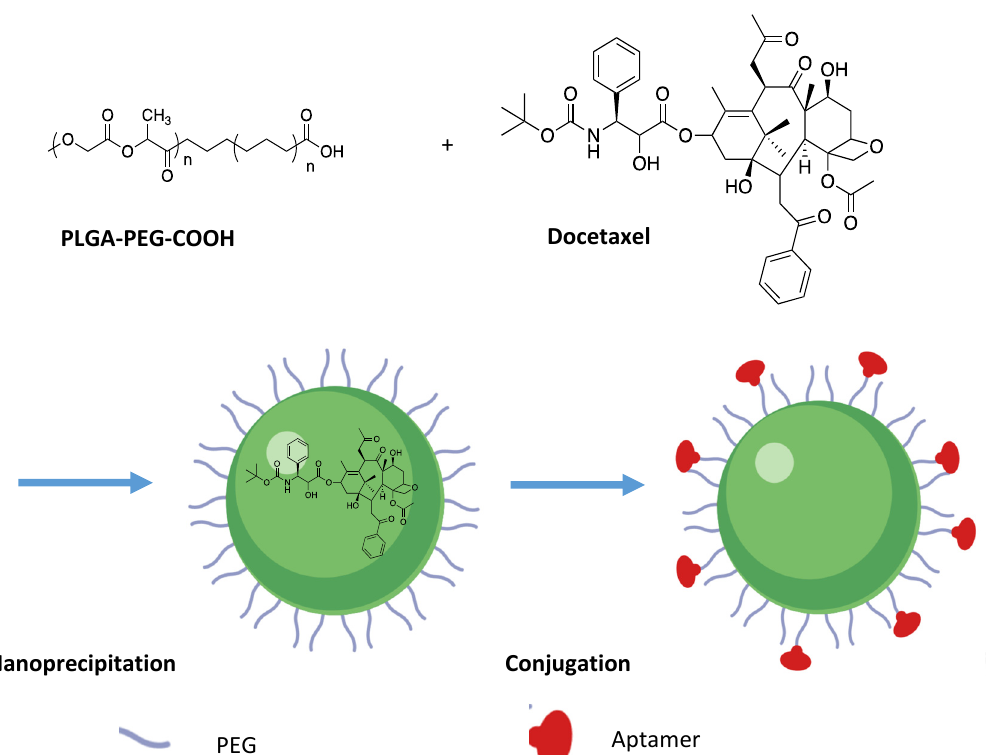
Figure 11. Synthesis of the nanoparticle PLGA-b-PEG-COOH: Docetaxel is encapsulated using the nanoprecipitation method. The nanoparticle is then covalently conjugated to aptamer (Apt) A10. Created with Biorender; modified from [167], Springer Science & Business Media; 2013.